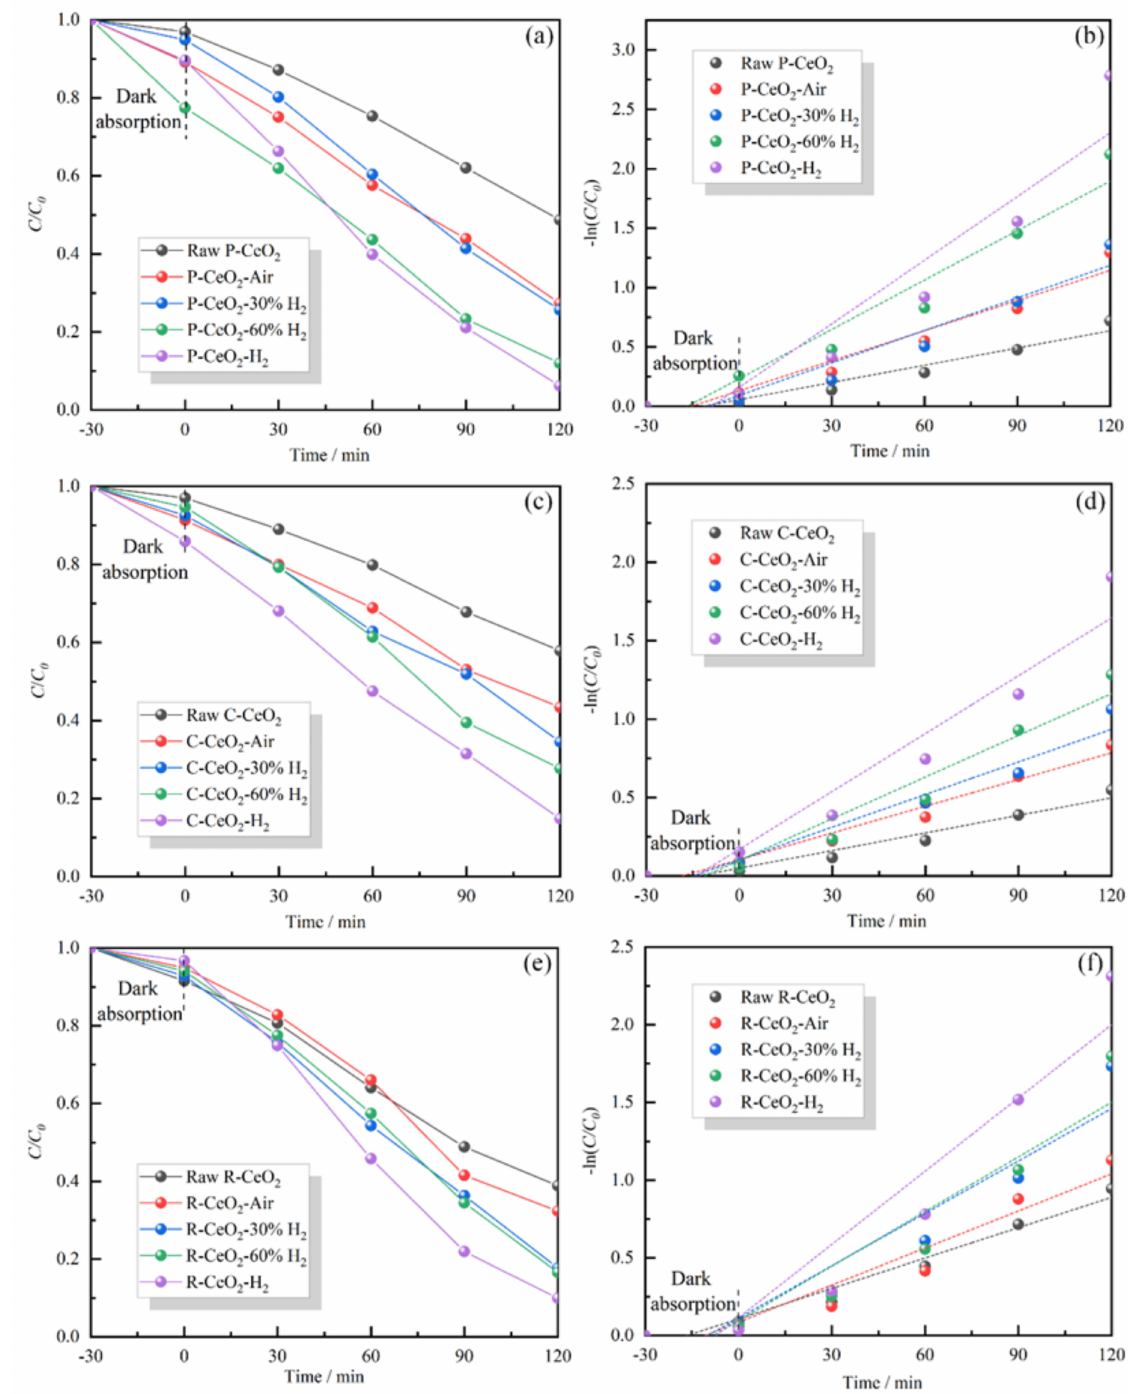
Figure 5. The photocatalytic degradation ratio and rate of P-CeO 2 ( a , b ), C-CeO 2 ( c , d ), and R-CeO 2 ( e , f ) calcining in different